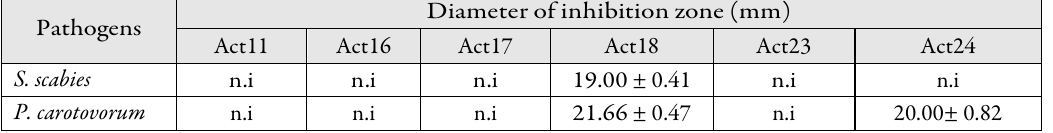
Table 3. Inhibition zone diameters (mm) of the phytopathogenic bacteria by the actinomycetes